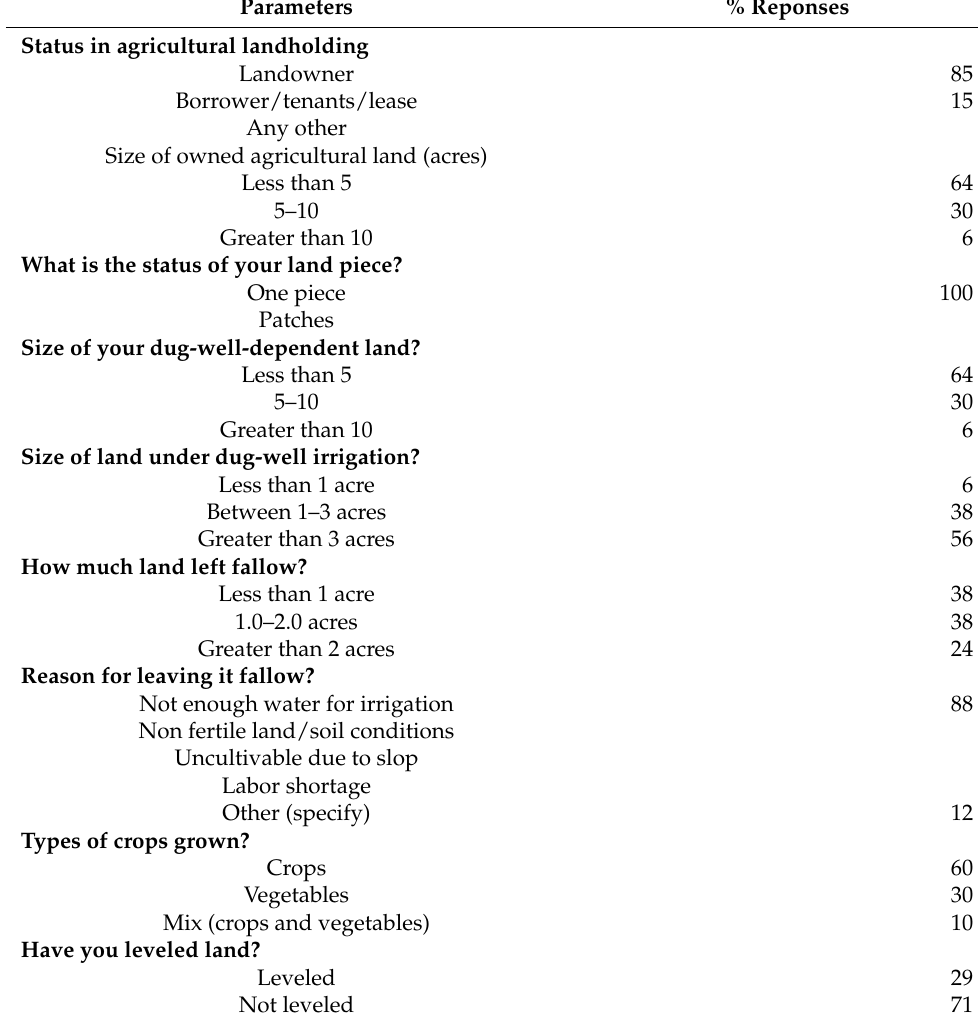
Table 3. Agricultural and other livelihood